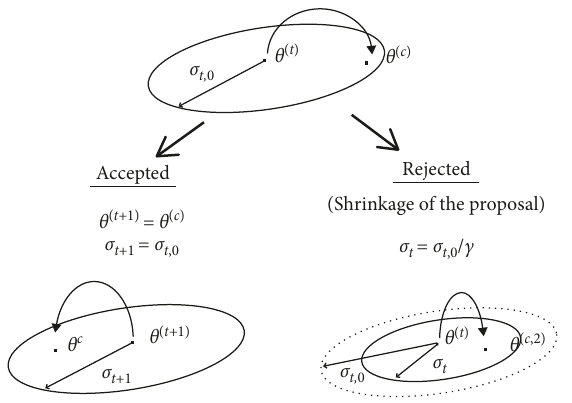
Figure 1: Delayed rejection illustrative sketch for a generic random variable ( σ t, 0 illustrates the variance of the random walk at an initial